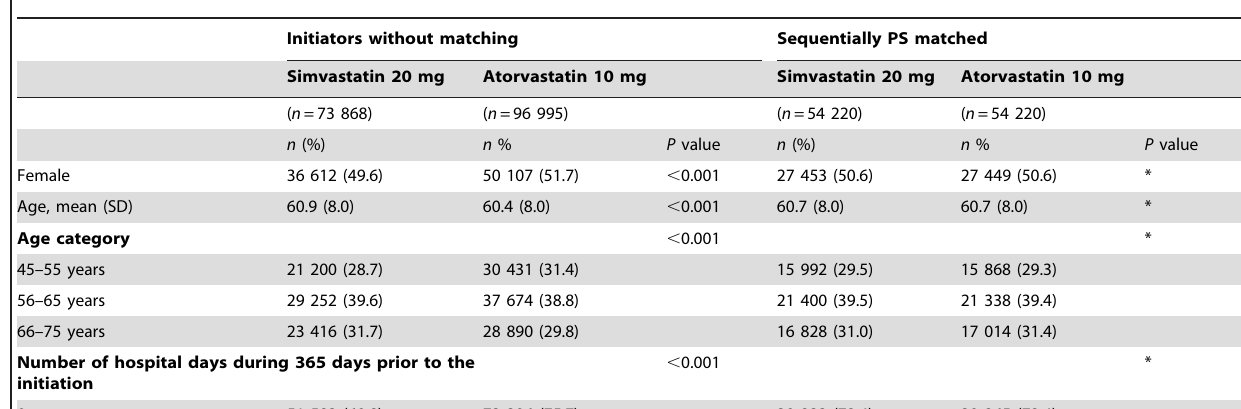
Table 1. Characteristics of the initiators of simvastatin and atorvastatin therapy between January 1998 and June 2006 in